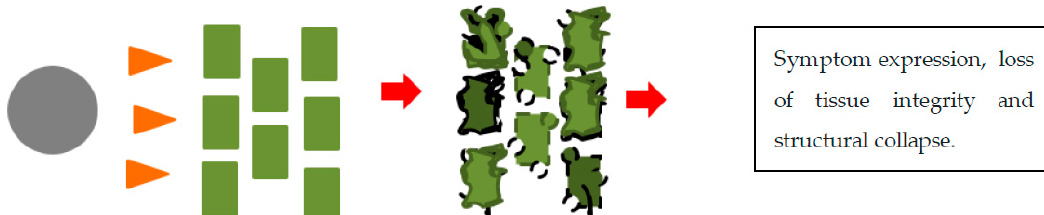
Figure 4. An illustration of necrotrophy between a plant pathogenic fungus and a plant. The grey circle represents a fungal spore, the orange arrows represent secreted pathogenicity and virulence factors. The green rectangles represent plant cells, the plant cells become deformed, ripped, and cell contents leak. Finally, symptoms are expressed.